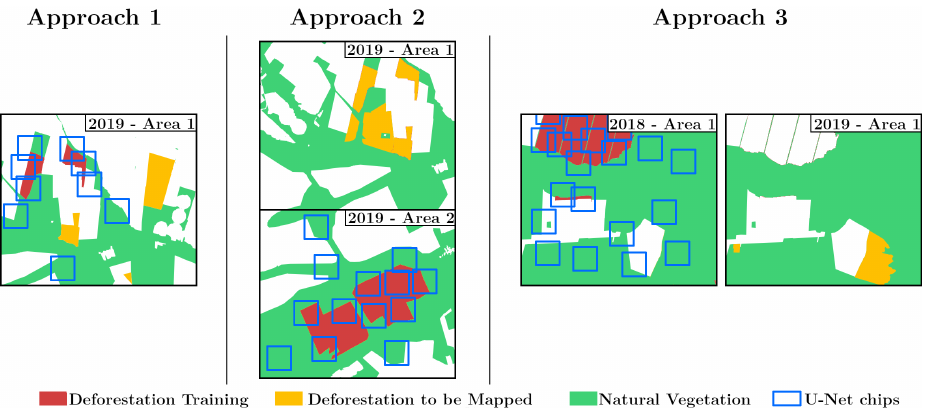
Figure 4. Strategies to select training samples. White colored areas represent past